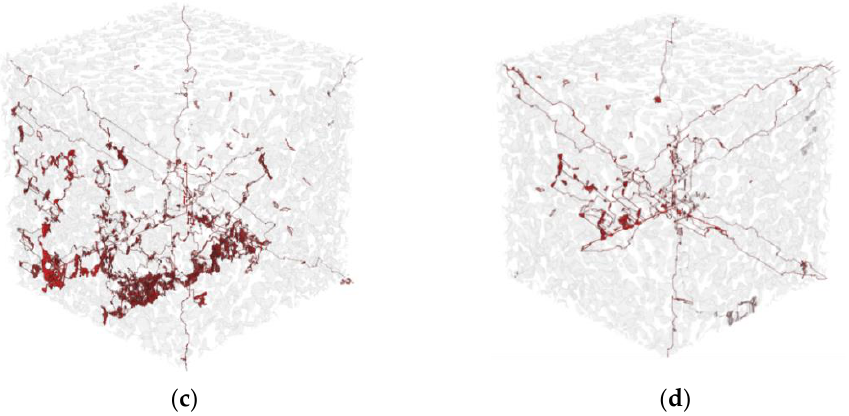
Figure 9. Pore paths for tortuosity in the specimens: ( a ) G33, ( b ) G47, ( c ) G60, and ( d ) G72 (note: the red regions represent the pore paths considered in the present study.).